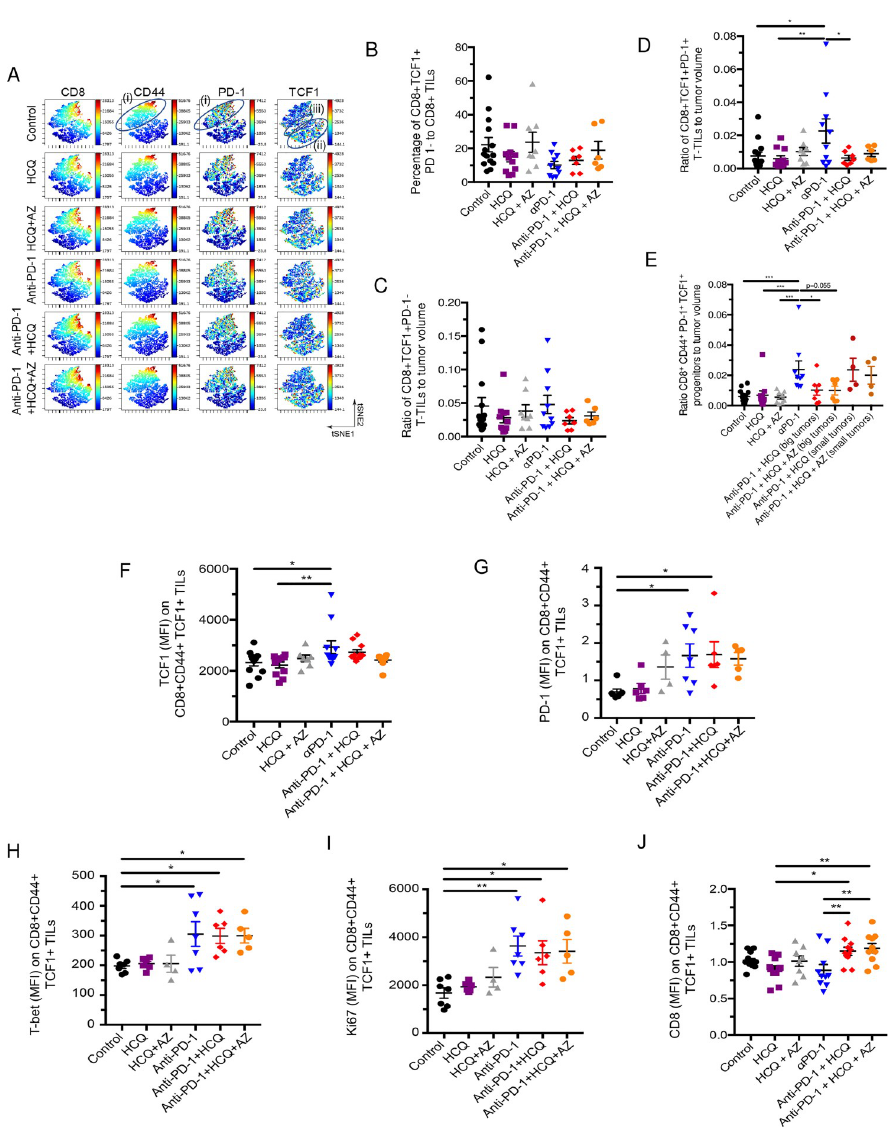
Fig 3. The effect of HCQ and AZ on the presence of CD8 + TCF1 + progenitor TILs. Mice were implanted with B16 tumours as described in Fig 1. Panel A: viSNE profiles of total CD8 + TILs. The figure shows the presence of the upper cluster of TILs expressing moderate to high levels of CD8, PD-1 and CD44 (island (i)), a second island (ii) expressing moderate levels of TCF-1 + with no PD-1; and island (iii) that co-expresses PD-1 + and TCF-1 + . Panel B : Percentage of CD8 + TCF-1 + PD-1 - TILs as a percent of total CD8+ TILs. Panel C: Ratio of CD8 + CD44 + TCF-1 + PD-1 - TILs relative to tumor volume. Panel D: Ratio of CD8 + TCF-1 + PD-1 + TILs relative to tumor volume. Panel E: Ratio of CD8 + CD44 + PD-1 + TCF-1 + progenitor TILs relative to tumor volume. A comparison of tumor volumes in mice where HCQ blocked the response to anti-PD-1 (big tumors) and mice where HCQ failed to block the response to anti-PD-1 (small tumors). Panel F: MFI of TCF-1 expression CD8 + CD44 + TCF-1 + PD-1 + TILs in response to anti-PD-1 alone or in combination with HCQ or HCQ/AZ. Panel G: MFI of PD-1 expression CD8 + CD44 + TCF-1 + PD-1 + TILs in response to anti-PD-1 alone or in combination with HCQ or HCQ/AZ. Panel H: MFI of T-bet expression CD8 + CD44 + TCF-1 + PD-1 + TILs in response to anti-PD-1 alone or in combination with HCQ or HCQ/AZ. Panel I: MFI of Ki67 expression CD8 + CD44 + TCF-1 + PD-1 + TILs in response to anti-PD-1 alone or in combination with HCQ or HCQ/AZ. Panel J: MFI of CD8 expression CD8 + CD44 + TCF-1 + PD-1 + TILs in response to anti-PD-1 alone or in combination with HCQ or HCQ/AZ.